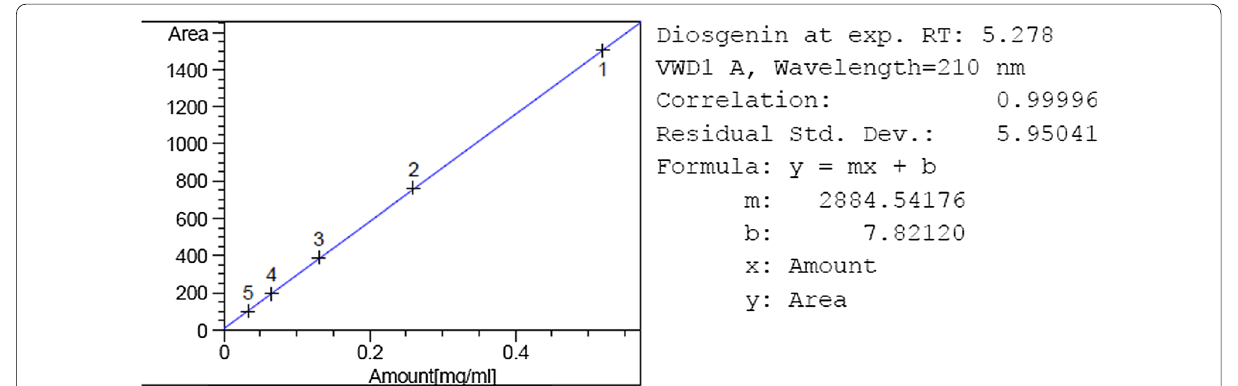
Fig. 7 Calibration curve of Diosgenin peak area Vs concentration of